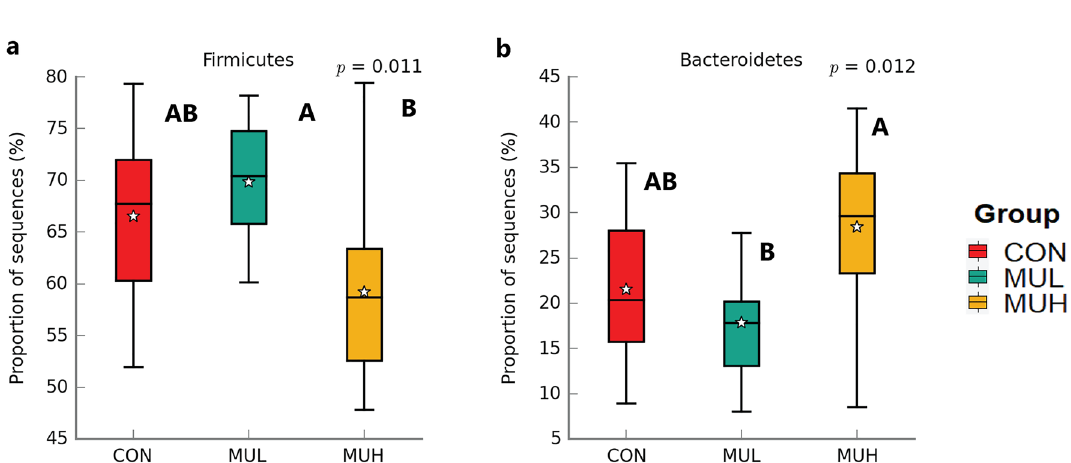
Figure 5. PCoA plot based on Bray–Curtis distance matrix used to compute beta diversity between caecal content samples of CON (red squares), MUL (green triangles), and MUH (yellow diamonds) at slaughter (42 d). The large, colored dots are the group centroids, while the colored plane curves are the standard deviational ellipses.